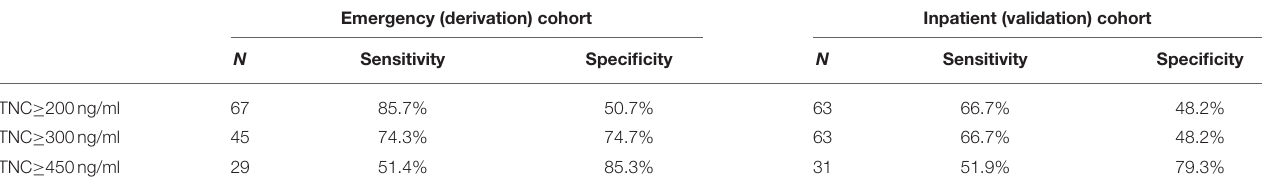
TABLE 4 | The diagnostic sensitivity and specificity of serum TNC and critical illness scores in emergency (derivation) and inpatient (validation)